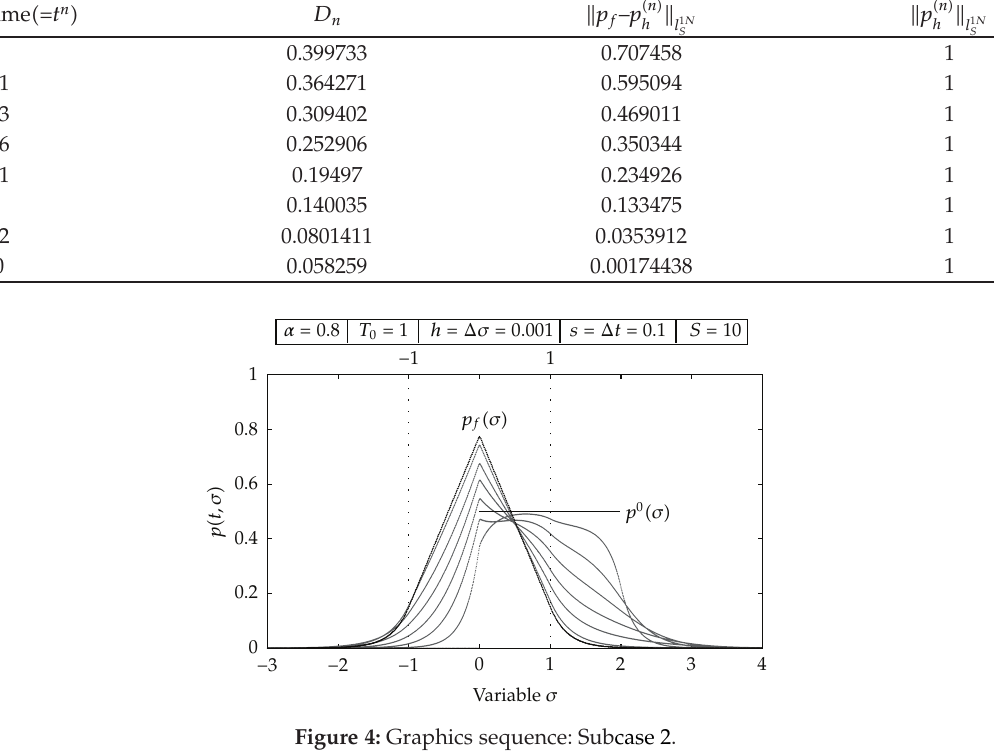
Table 2: Numerical results: Subcase 2.